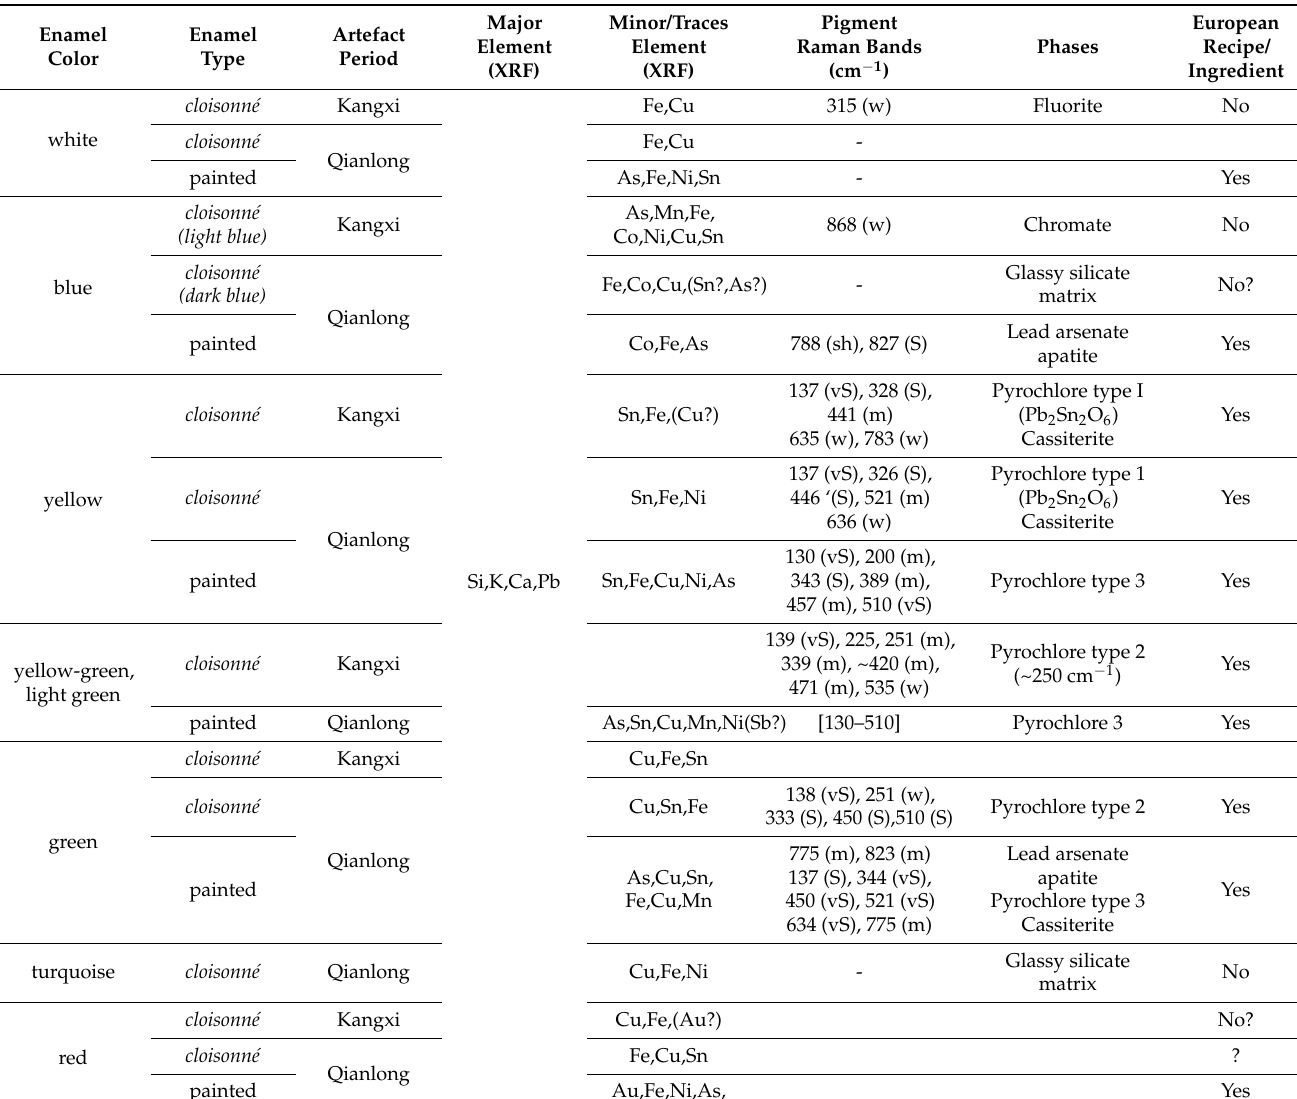
Table 5. XRF and Raman results of the different colored enamels studied (sh: shoulder, w: weak, m: medium, S: strong, vS: very strong).